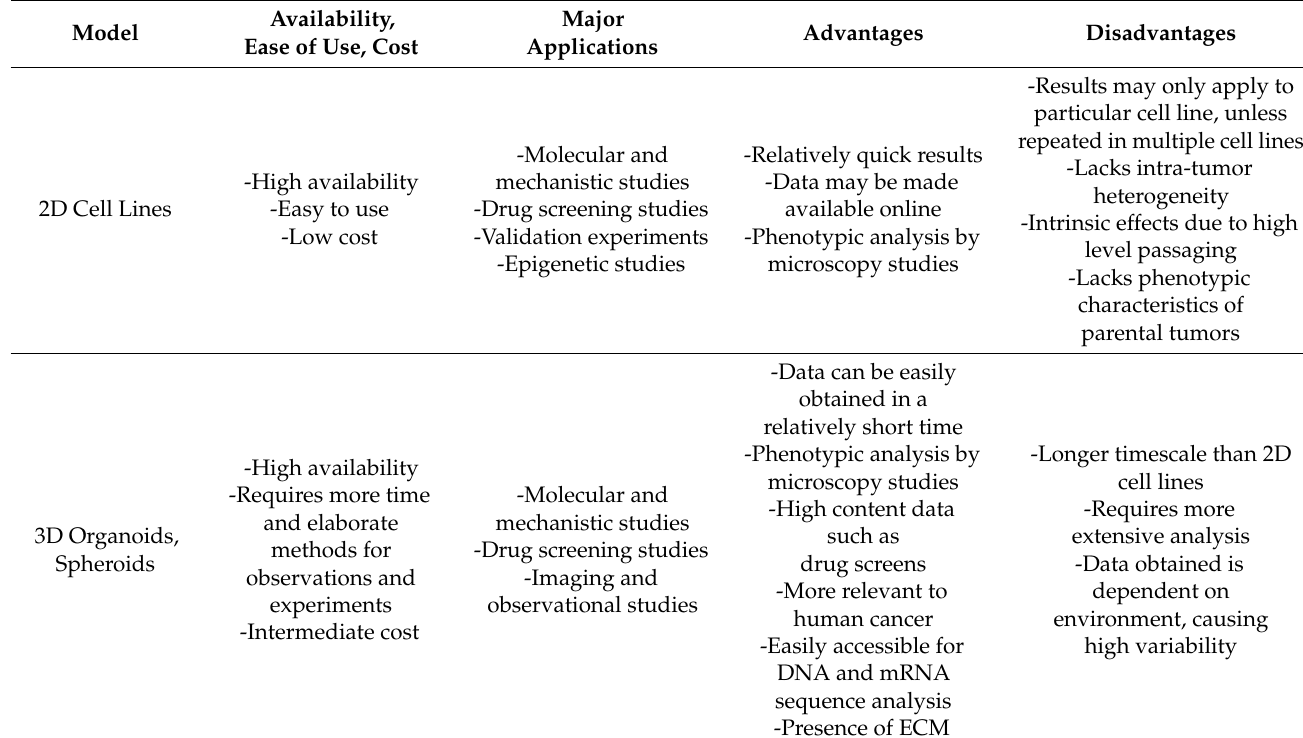
Table 1. Advantages and disadvantages of models for PCa